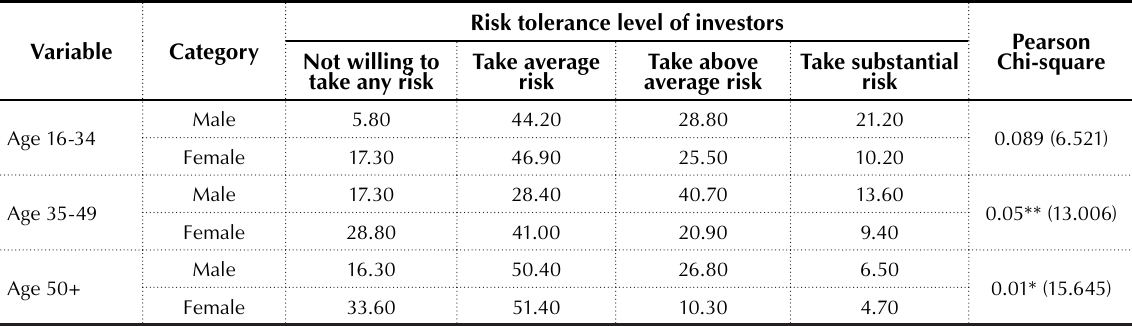
Table 4. Comparing male and female investors within age categories